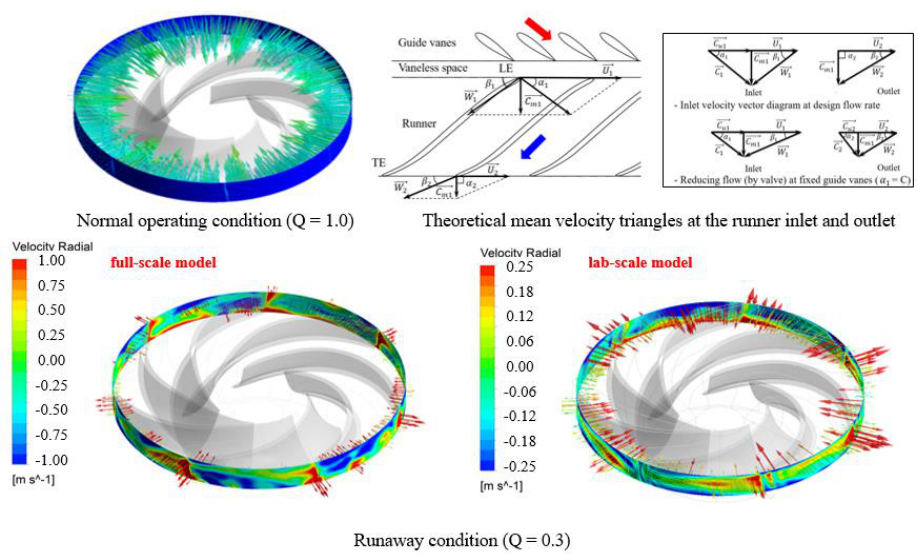
Figure 15. Comparison of the instantaneous radial velocity contours and vectors in the vaneless space between the models.